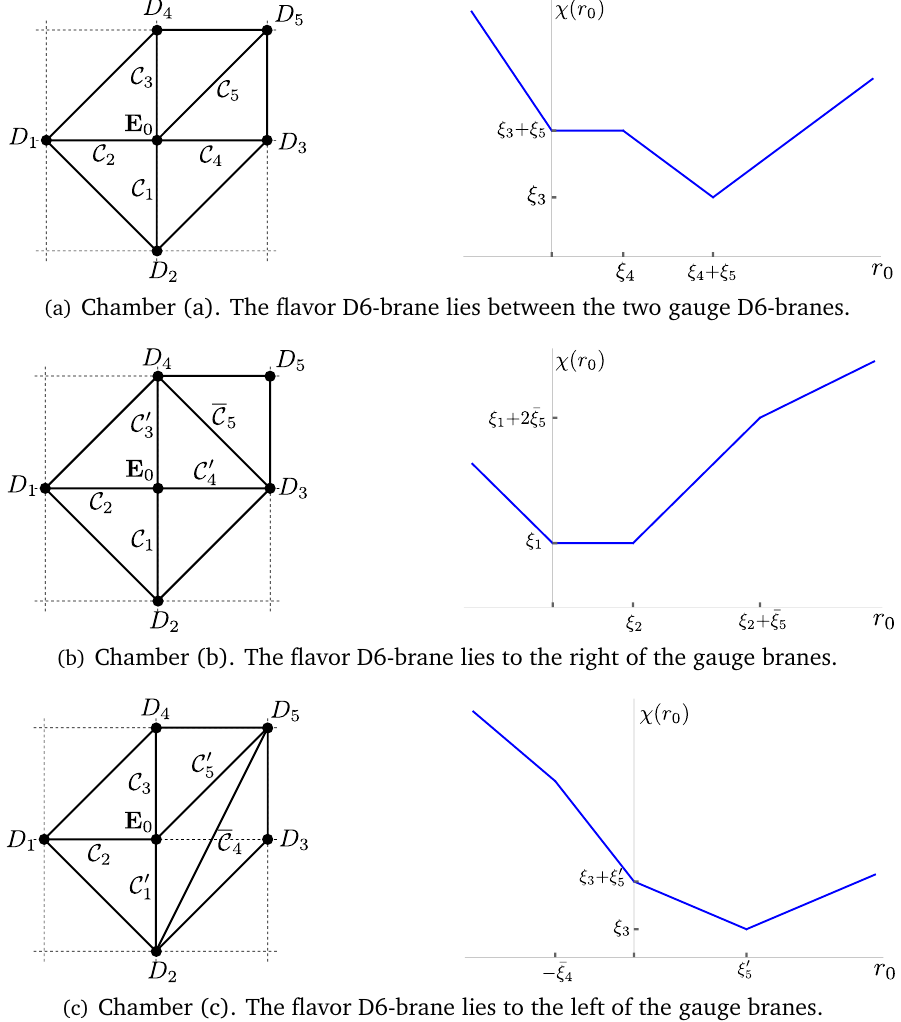
singularity with a “vertical reduction,” and 2 ) 0